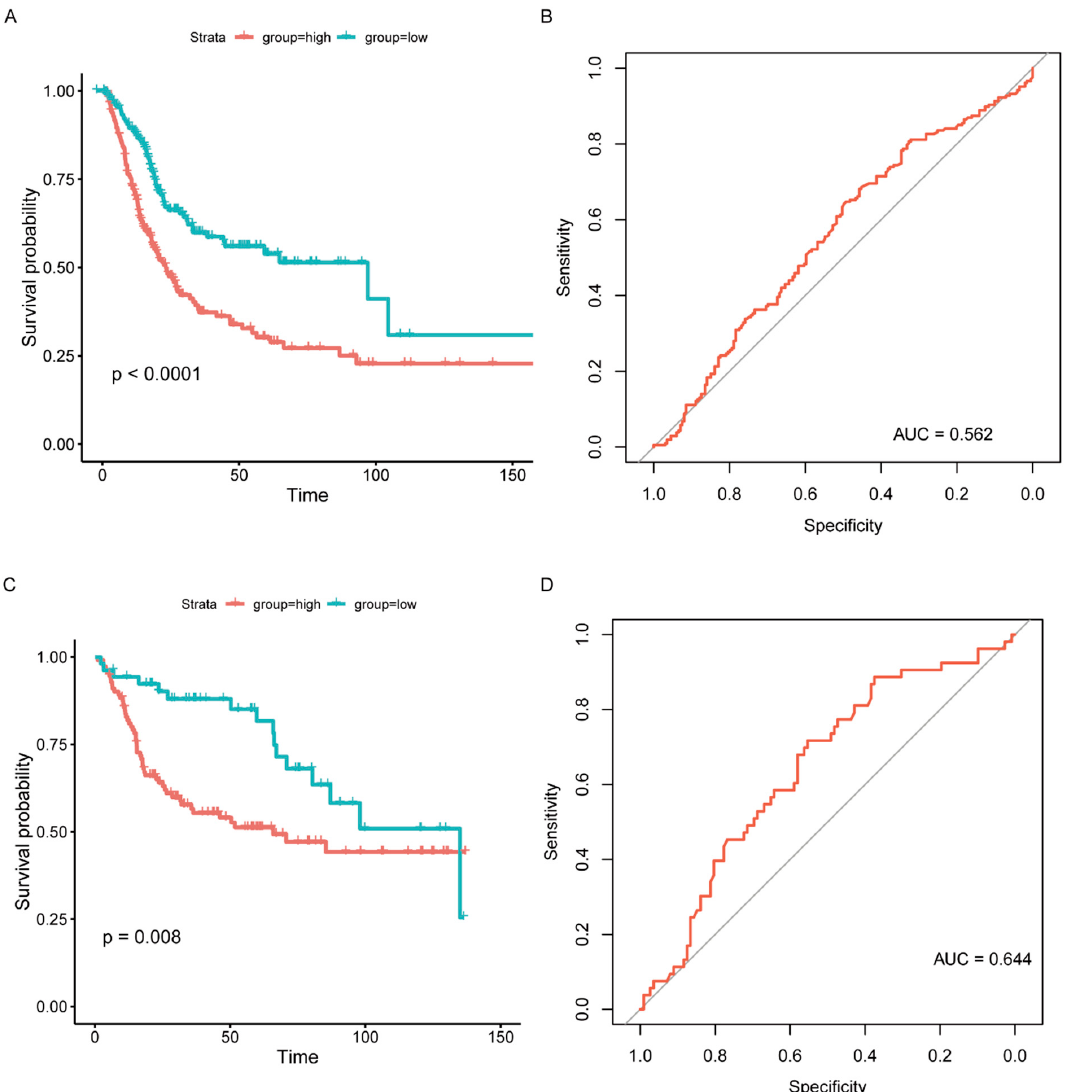
Figure 5. Prognostic model validation and survival outcomes of different risk groups. ( A ) Kaplan– Meier curves of different risk groups in the TCGA cohort. ( B ) ROC curve of the prognosis model (TCGA). ( C ) Kaplan–Meier curves of different risk groups in the GSE13507 cohort. ( D ) ROC curve of the prognosis model (GSE13507).